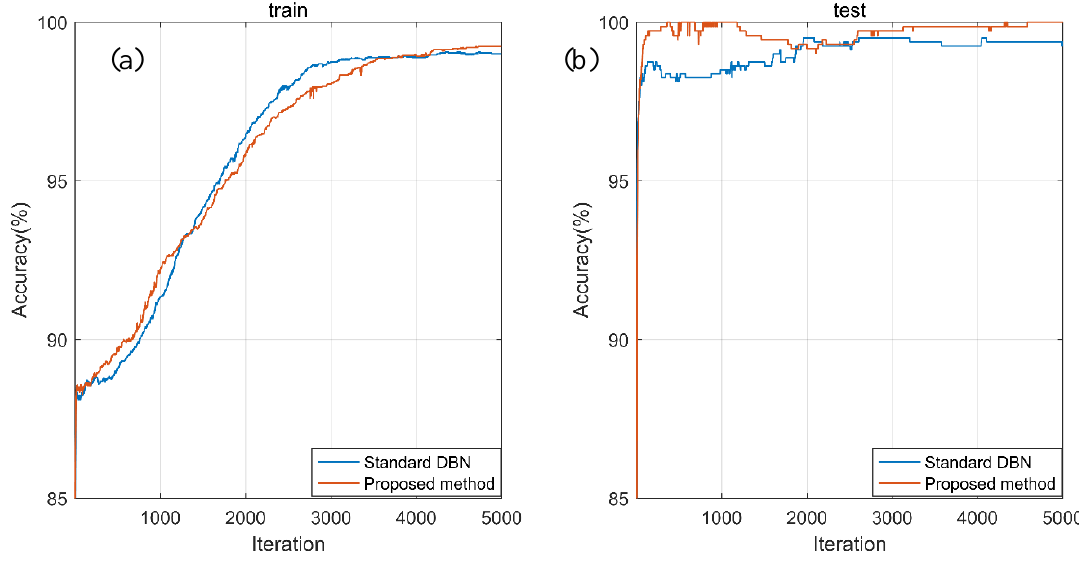
Figure 12. Accuracy trends of ( a ) training and ( b ) testing models for roller fault degree recognition.